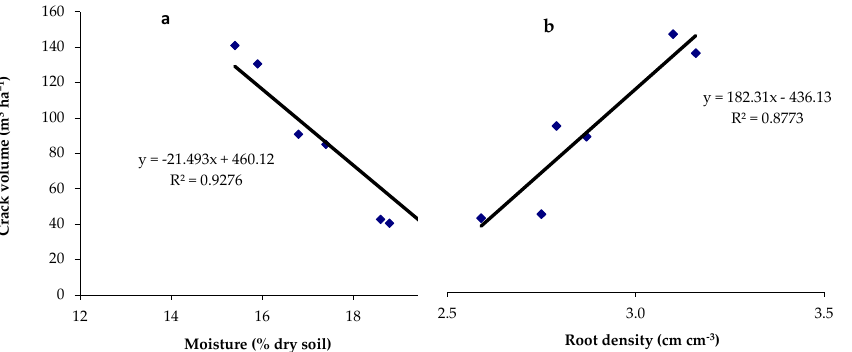
Figure 8. Linear regressions between the crack volume and ( a ) the gravimetric soil moisture content ( p value = 0.0001) and ( b ) the root density ( p value = 0.0059).